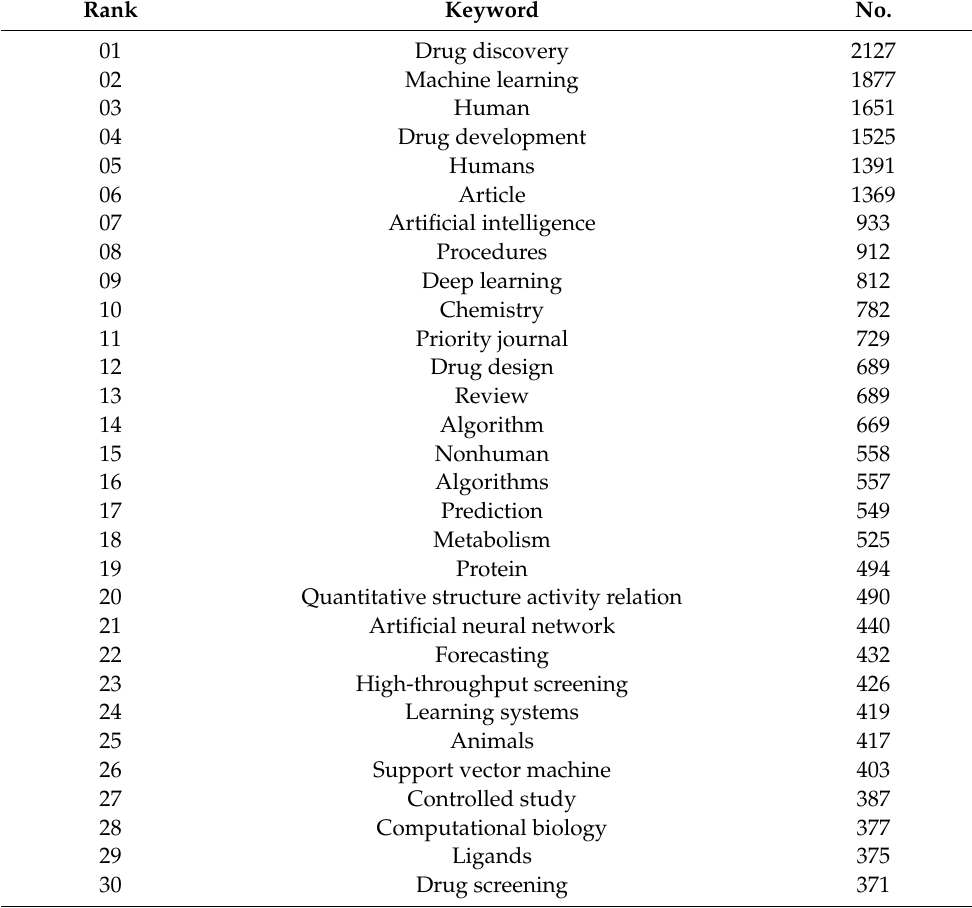
Table 8. Overview of the most frequently used keywords. Rank Keyword No. Drug